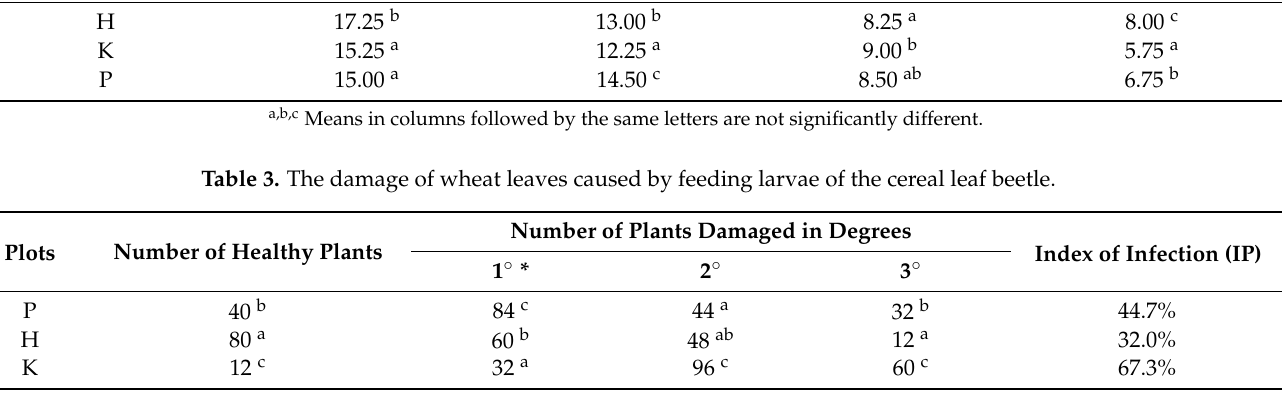
Table 2. The mean number of O. melanopus larvae for three treatments. Treatment